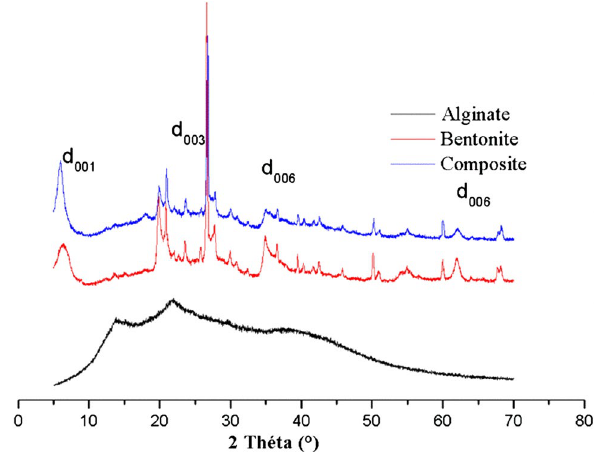
Fig. 2 X-ray diffraction patterns of bentonite materials